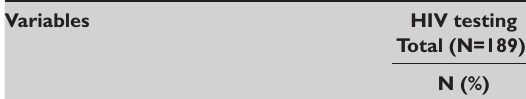
Table 1: Descriptive statistics of health belief model (HBM) constructs and HIV testing